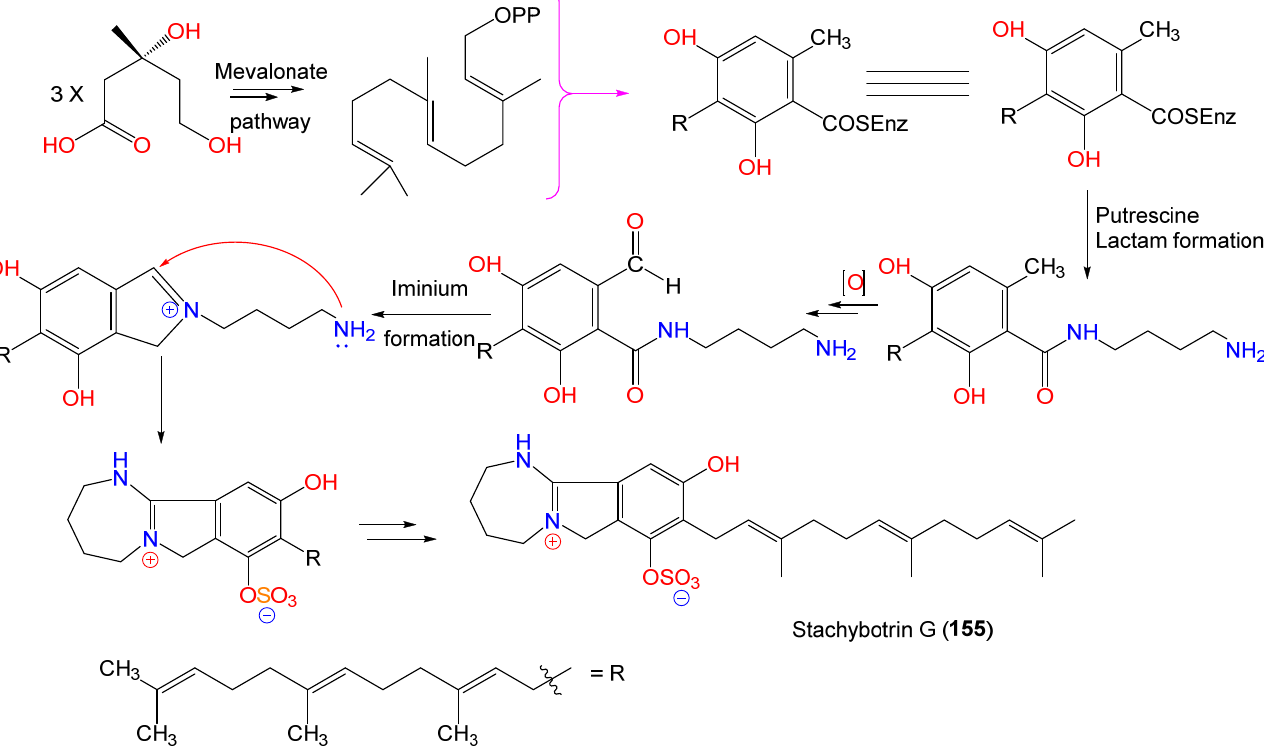
Figure 19. Structures of isoindoline derivatives ( 147 – 155 ) reported from S . chartarum . It had no cytotoxic (versus P388, A-549, HL-60, BEL-7402, and Hela cells), antiviral (versus HIV and H1N1), and antibacterial (versus M. phlei , S. aureus , Colibacillus sp., and Blastomyces albicans ) potential [105]. Ma et al. proposed that 155 is generated through both mevalonate and polyketide pathways, with subsequent modifications, including ami- dation, cyclizing, and sulfation (Scheme